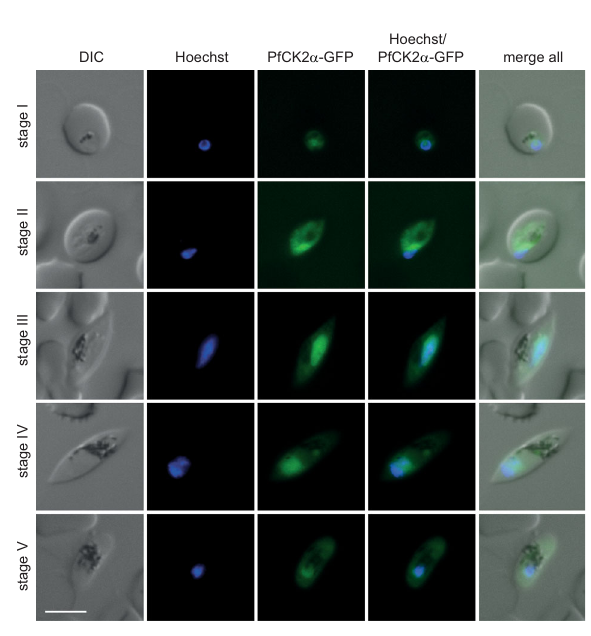
Fig. 5 Expression and localisation of PfCK2 α -GFP during gametocytogenesis (stage I – V) by live cell fl uorescence imaging. Representative images are shown. Nuclei were stained with Hoechst. DIC, differential interference contrast. Scale bar = 5 µ m.